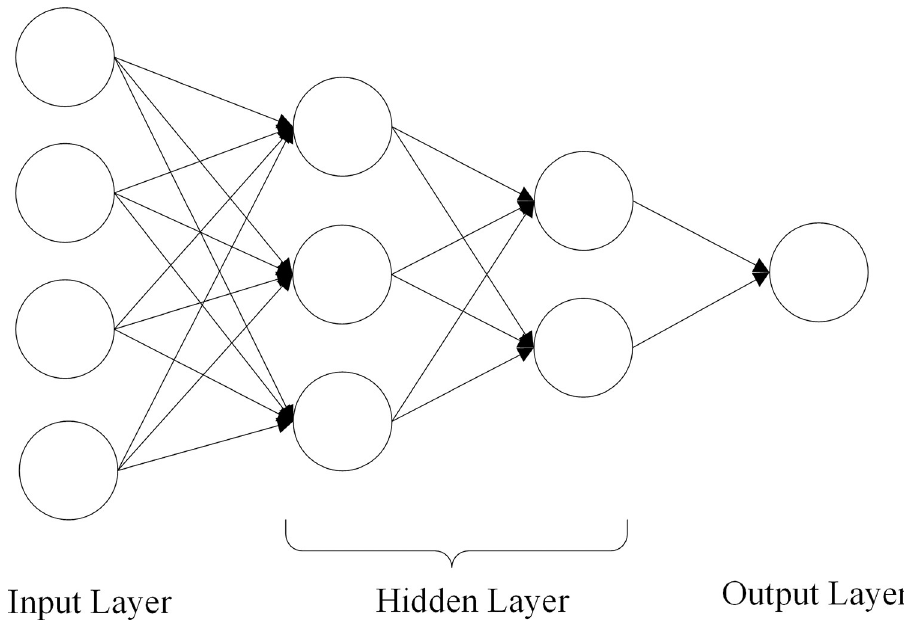
Fig 2. An illustrative structure of